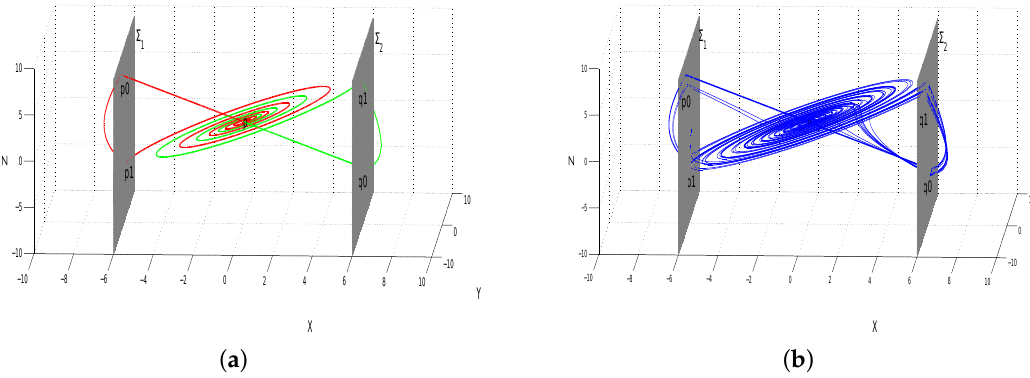
Figure 3. ( a ) The two homoclinic orbits of Example 3 are represented by red and green lines, respectively, which are both homoclinic to the saddle-focus equilibrium point p ; ( b ) A chaotic invariant set of Example 3 near the two homocliic